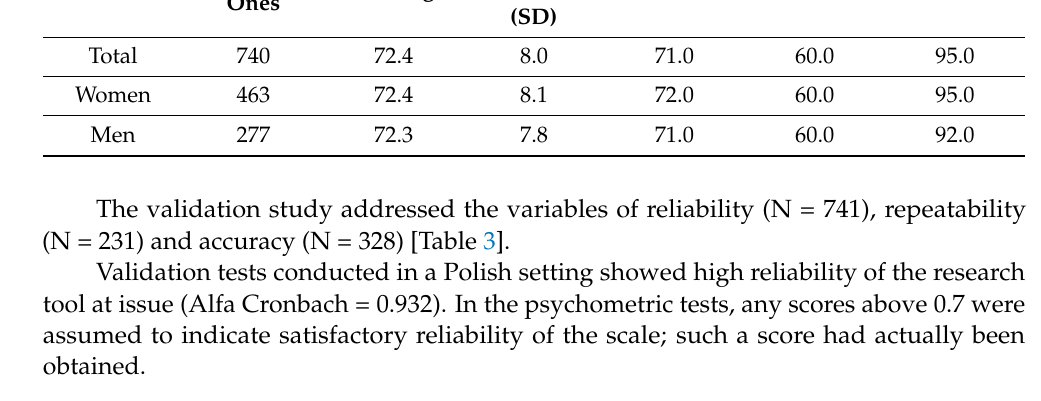
Table 2. Stratification by gender and mean age of the study subjects. N of Valid